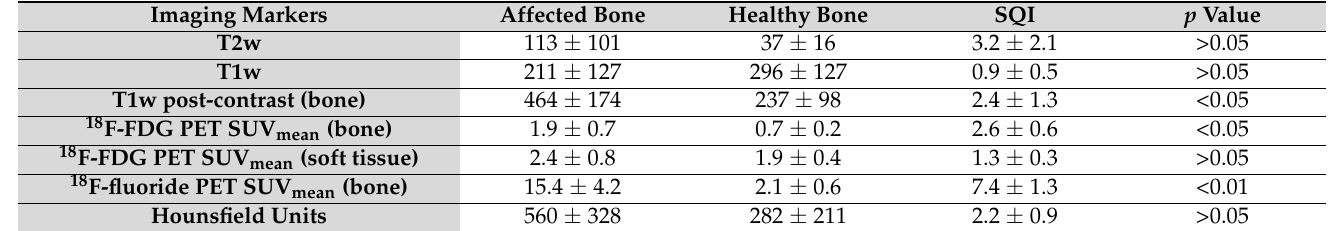
Table 2. Quantitative imaging markers in affected jawbone and healthy jawbone. Indicated as Mean ±